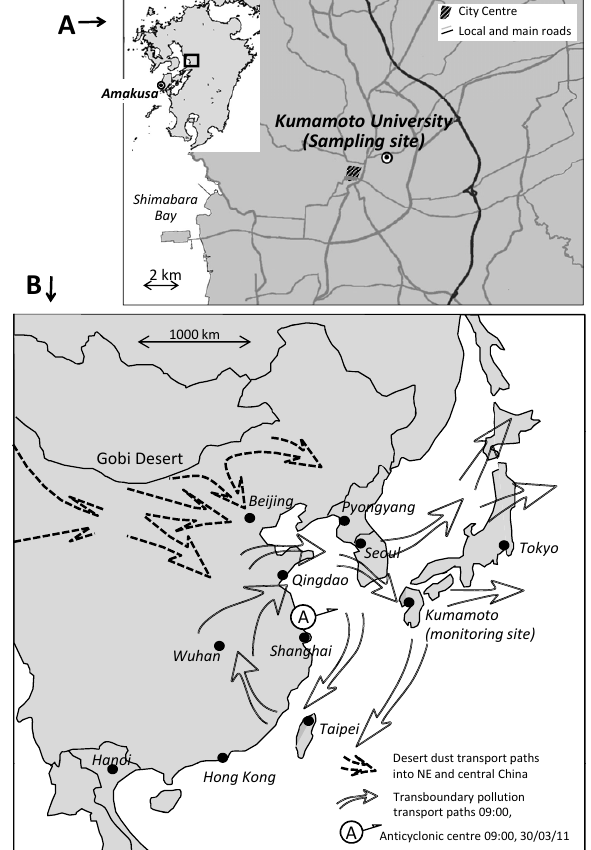
Fig. 1. Top: a simplified map of the area around the sampling site (rectangle in the inset) showing major roads including the Kyushu Expressway (darker line). Bottom: location map showing Kumamoto monitoring site and overviewing the area affected by the transboundary expulsion of anthropogenic aerosols from China into the NW Pacific region. Arrows depict typical atmospheric cir- culation patterns driving the pollution eastward out from the main- land, in this case by an anticyclone centred near Shanghai during the sampling period at the end of March 2011. The main source ar- eas of springtime desert dust intrusions into the area are also shown (Wang et al.,